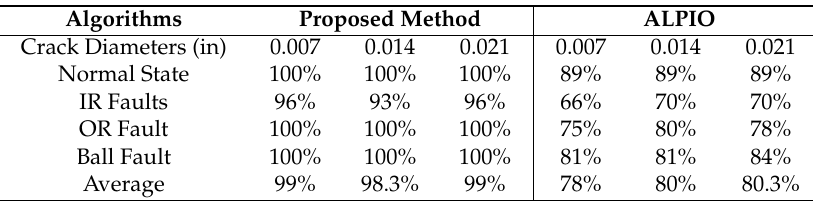
Table 3. Fault diagnosis results for Dataset 1 for the proposed method and ALPIO when torque load = 0 hp. Algorithms